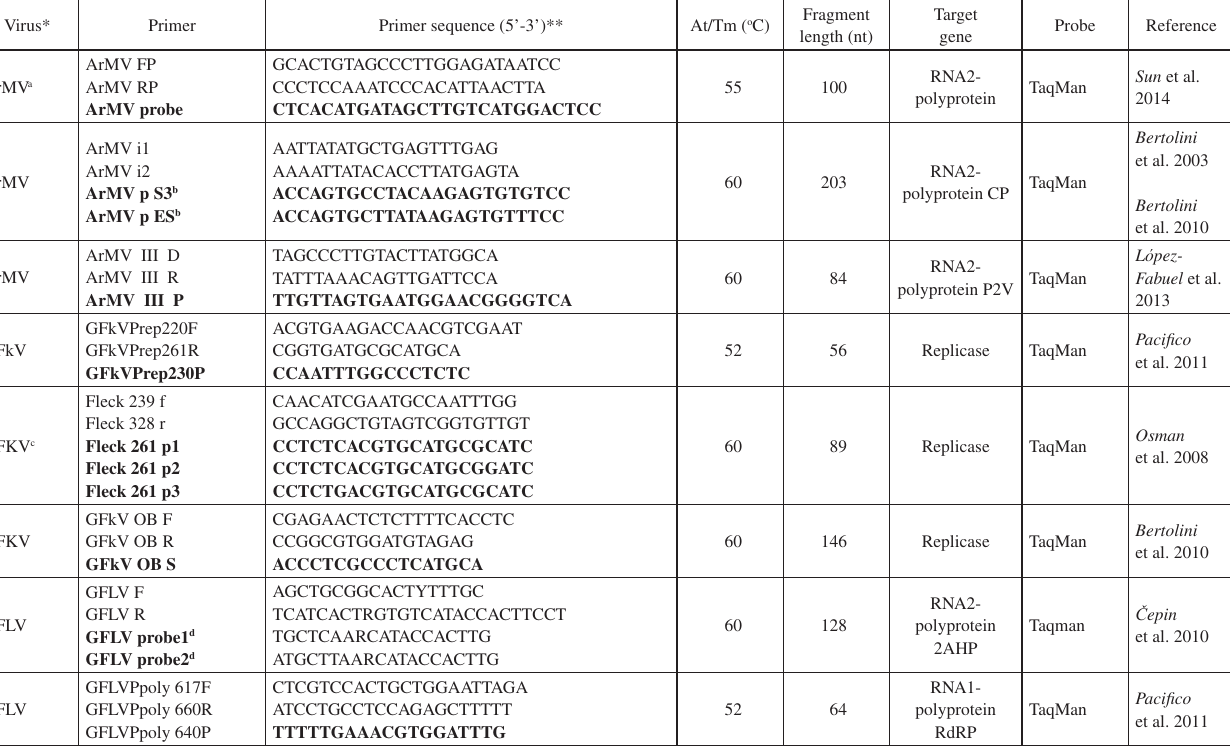
Table 2. Virus specific